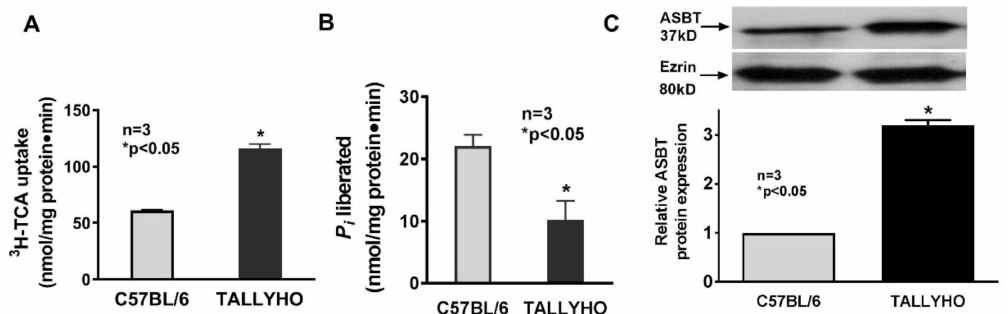
Figure 4. Alterations in Na–bile acid cotransport and Na-K-ATPase in villus cells from TALLYHO mice model of obesity. ( A ) Na–bile acid cotransport was significantly increased in villus cell BBM from TALLYHO mice compared to C57BL / 6 mice. ( B ) Na-K-ATPase activity was significantly reduced in villus cell homogenates from TALLYHO compared to C57BL / 6 mice. ( C ) ASBT protein expression was significantly increased in villus cell BBM from TALLYHO mice compared to C57BL / 6 mice.